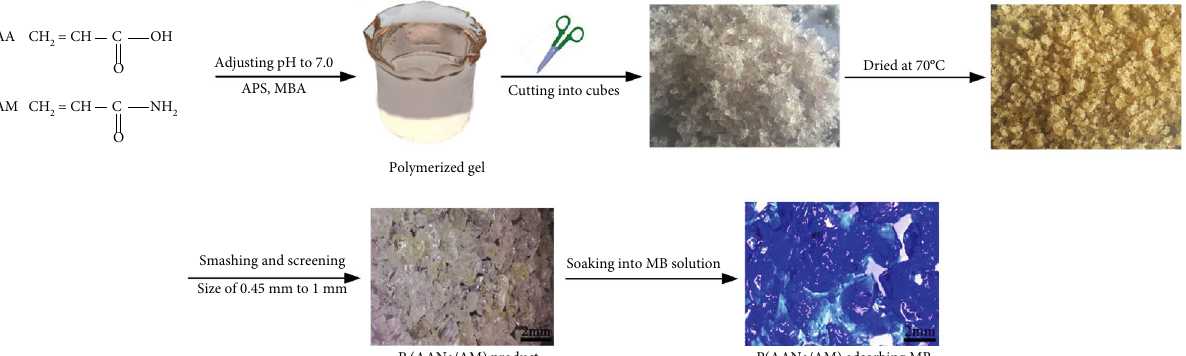
Adjusting pH to 7.0